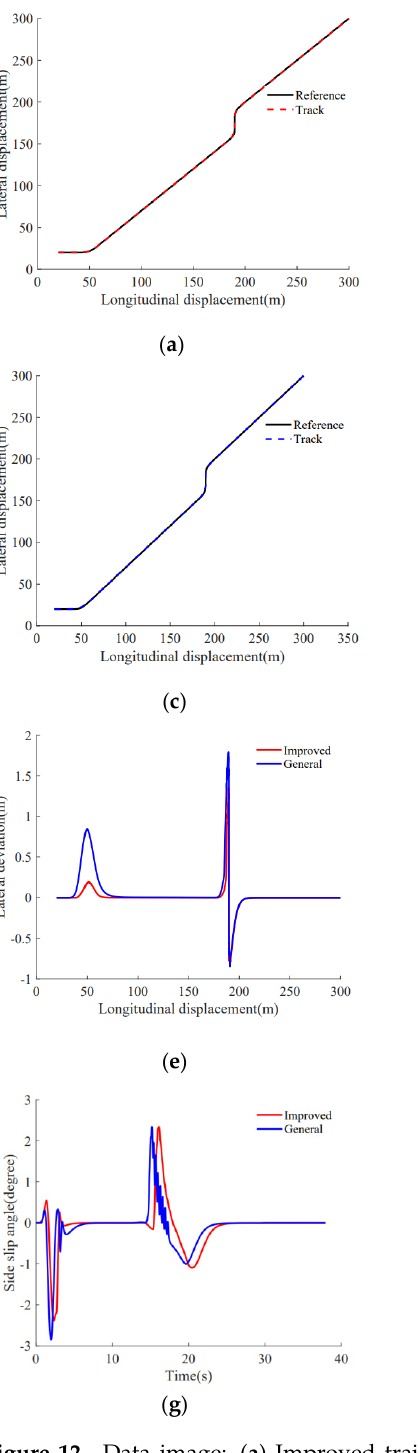
1 m/s 2 . The Matlab-Carsim HIL simulation platform test is shown in Figure 13. Figure 13a,b are the images displayed by Carsim in the Matlab-Carsim HIL simulation platform. Figure 13c,d are the test images of the bench in the Matlab-Carsim HIL simulation plat- form.